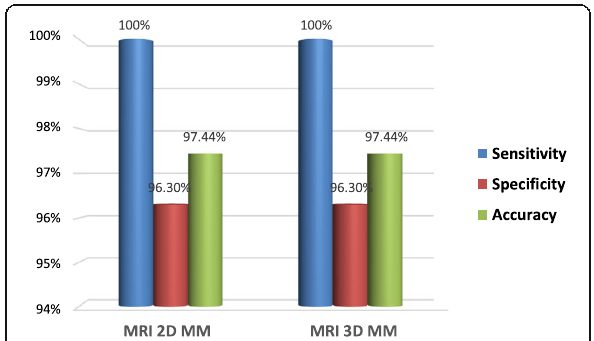
Fig. 7 Comparison of sensitivity, specificity, and accuracy between 2D VS 3D in detecting MM tears